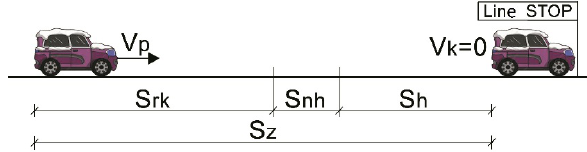
Figure 2: Diagram of the impact of the three quantities making up